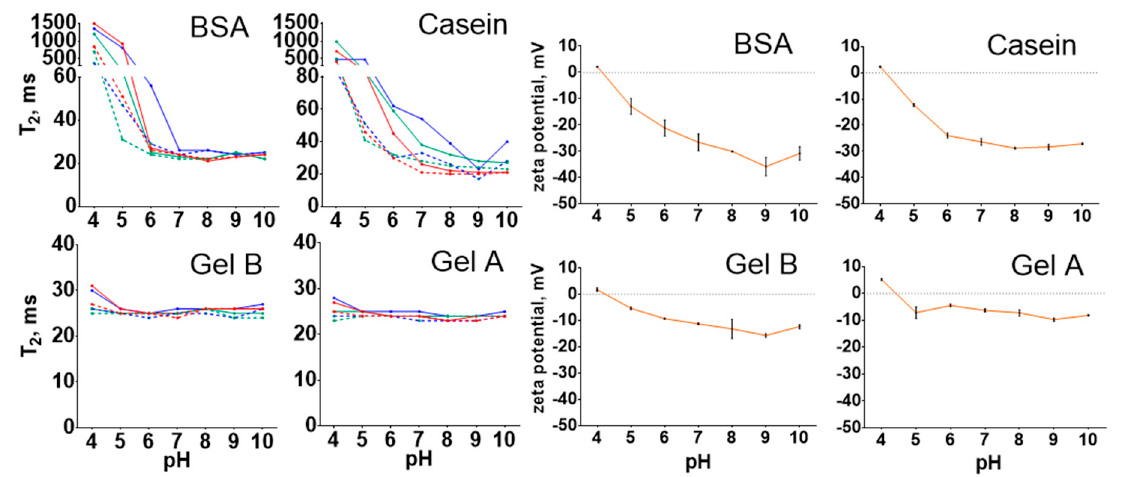
Figure 8. The T2 relaxation times of Fe@C-NH 2 /Protein/G diluted in buffers with different pH and ionic strength values and the zeta potentials of Fe@C-NH 2 /Protein/G. “BSA”, “Casein”, “Gel B”, and “Gel A” indicate coating protein. T2 in 0.15 M (red line), 0.5 M (green line), and 2 M (blue line) buffers at 0 (dashed line) and 24 h (solid line), n = 3, mean ± SD.